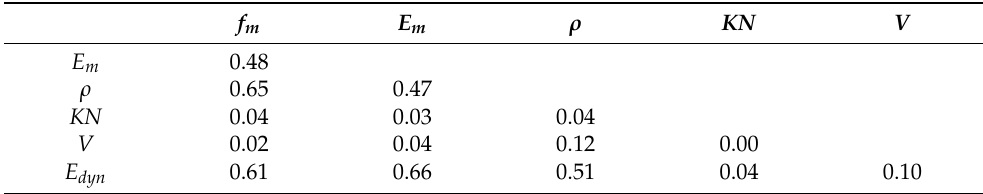
Table 4. Coefficients of determination between several material properties ( f m = bending strength; E m = static modulus of elasticity; ρ = density; KN = knot parameter, visually measured; V = velocity; E dyn = dynamic modulus of elasticity).